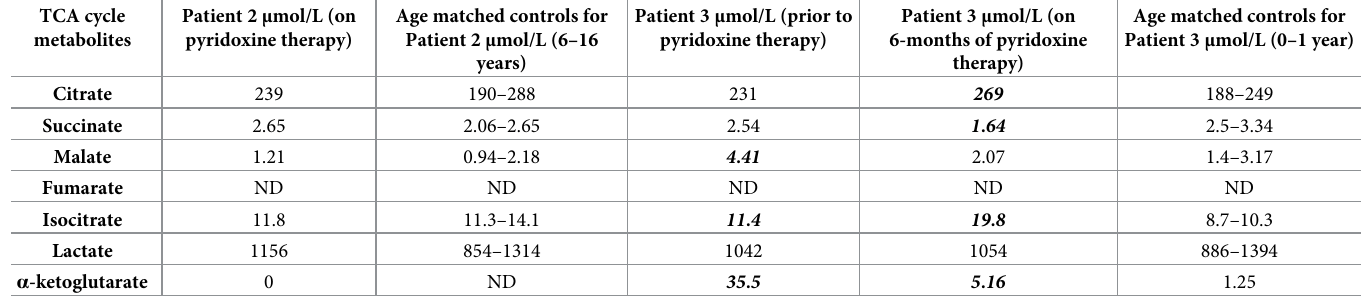
Table 2. TCA cycle metabolites of Patient 2 and Patient 3 with PDE- ALDH7A1 .